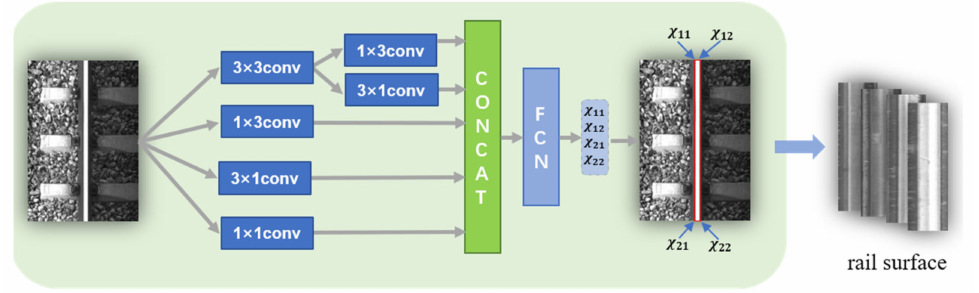
Figure 3. Rail cropping